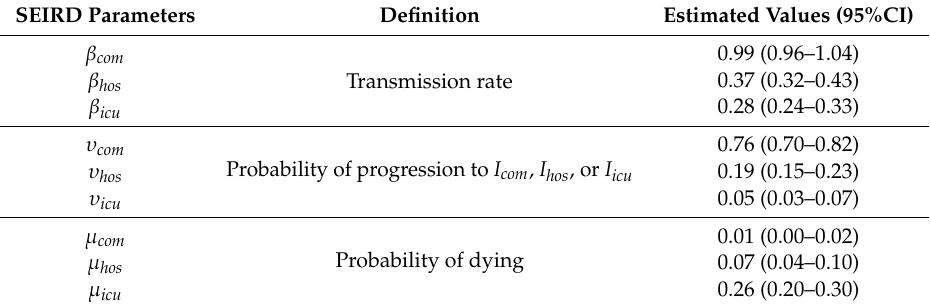
Figure 3. Number of estimated and reported patients in Intensive Care Unit and deaths in Sicily (Italy) from 24 February to 24 March 2020. The SEIRD model was fitted to the reported number of patients admitted to Intensive Care Unit (ICU) and deaths. Blue and red dots represent the number of reported ICU patients and deaths, respectively, while the lines represent their estimates and 95% confidence intervals through the SEIRD model. Table 2. Best-fitting parameters in absence of control measures.